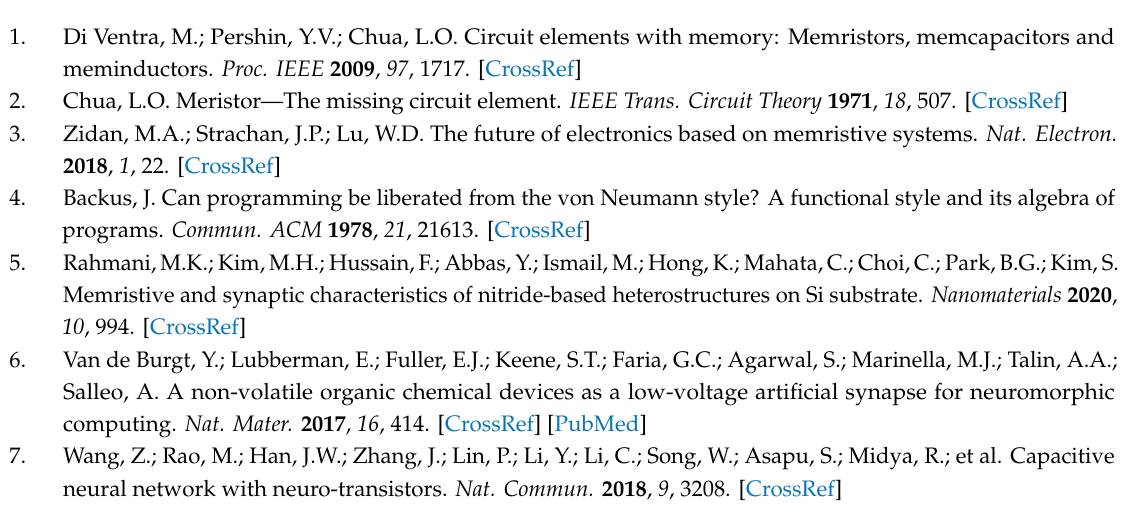
Figure S1: High resolution XPS spectra, Figure S2: SEM and EDX spectra, Table S1: Electronic properties of the ITO / ReO 3 @ReS 2 / Al, Figure S3: Device area dependent I vs. V plot, Figure S4: Normalized resistance ( RR o − 1 ) vs. temperature ( T-T o ) plot, Figure S5: SEM image of the ITO / ReO 3 @ReS 2 / Al device, Figure S6: The I vs. V plot in the voltage range ± 5 V, Figure S7: The ln J vs. E plot, Figure S8: The ln JE − 1 vs. E 1 / 2 plot, Figure S9: The ln J vs. k b − 1 T − 1 Arrhenius plot, Figure S10: The ln IT − 2 vs. V 1 / 2 plot, Figure S11: The C vs. V plot, Figure S12: The I vs. V plot in the voltage range ± 7 V, Scheme S1: Energy band and charge density diagram, Figure S13: The C vs. V plot at scan frequency of 1 kHz, Figure S14: The C vs. V plot, Figure S15: Nyquist plot of the impedance